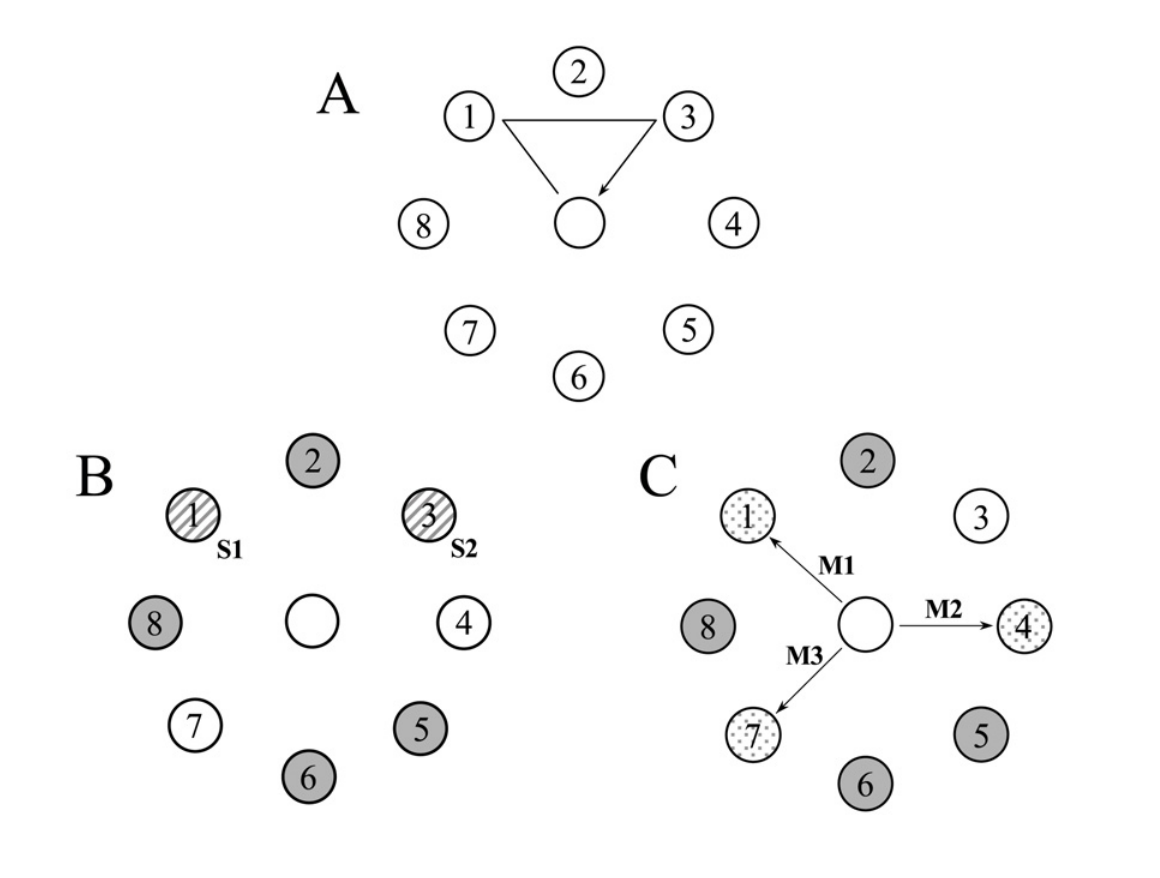
FIGURE 3. Examples illustrating the data-analysis procedures. (A) Starting with the position of the first cue, positions are numbered sequentially in the direction of the second cue. The first cue is always in position 1 and the second cue in position 3. (B) With the subject’s gaze at fixation, the sensory account of IOR predicts that inhibition should only be observed at positions where cues occurred (S1 and S2, indicated with a diagonal fill pattern). (C) The motor account of IOR predicts that responses along the vectors representing previously executed or cued movements should be inhibited. Thus, IOR should be observed at M1, M2, and M3, indicated with a dotted fill pattern. Note that IOR occurring at position 1 is ambiguous, since both the sensory and motor accounts predict IOR there. Finally, positions 2, 5, 6, and 8 (shaded) are neutral, since neither account predicts IOR at these